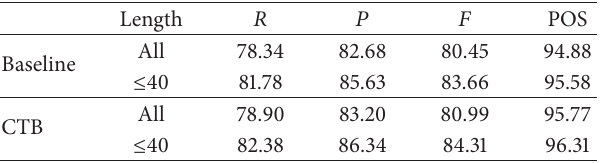
Table 6: POS and parsing accuracy on CTB in graph-based OOV model.